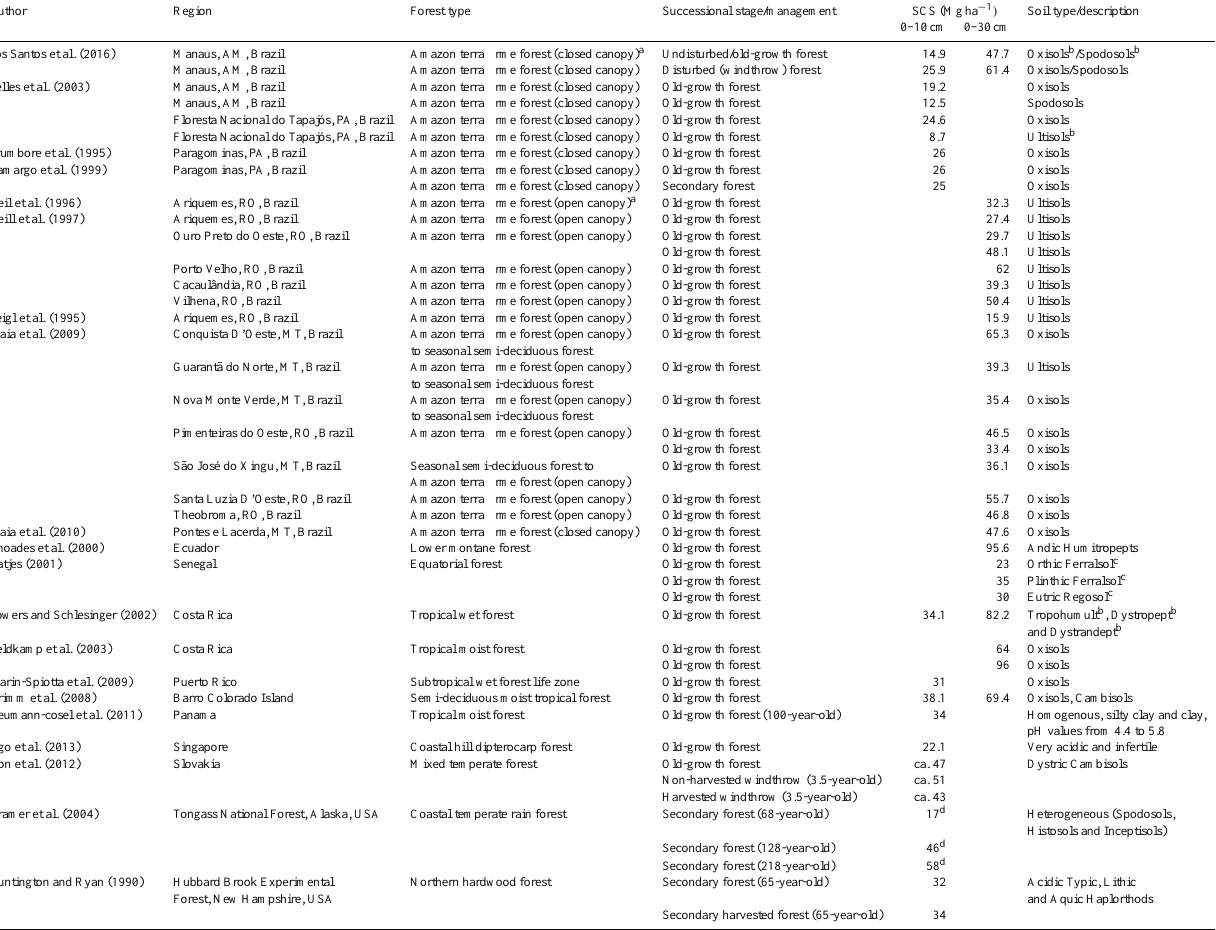
Table 2. Estimates of soil carbon stock (SCS) from this and other studies conducted in different tropical, subtropical, and temperate forests.